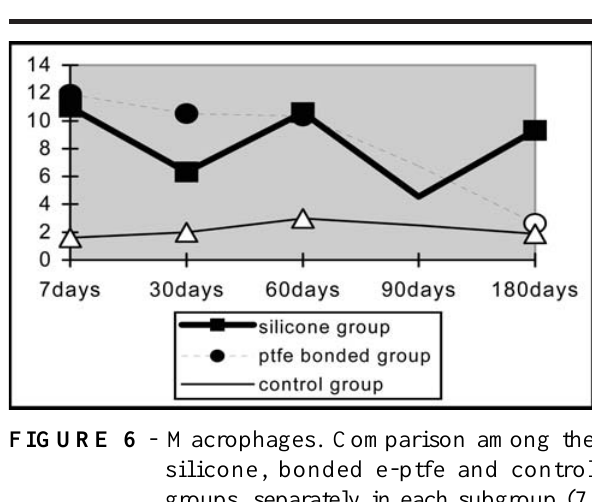
FIGURE 5 - Macrophages. Comparison among subgroups (7, 30, 60, 90 and 180 days), in each group separately. The significant value is indicated with a dark line and the comparison in a light one